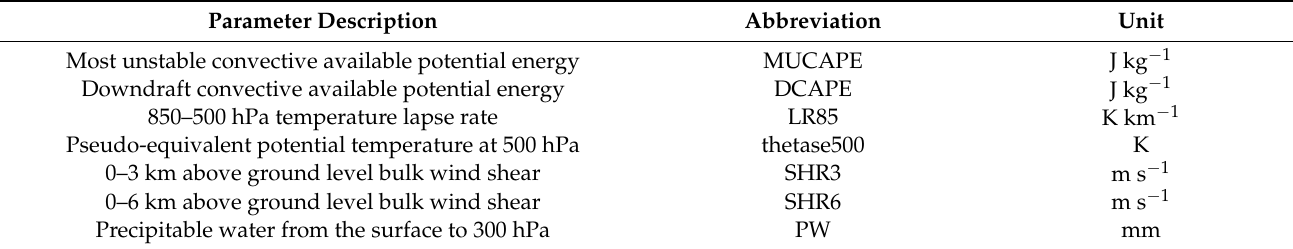
Table 2. Parameters computed from proximity soundings in this